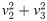
Polytope of possible flux configurations.(A) Example metabolic network with known exchange fluxes v1 and vμ, and two unknown inner fluxes v2 and v3 forming a loop. The upper bounds for fluxes v2 and v3 are UB2 and UB3. Any value of v3 ∈ [0, UB3] satisfy the metabolites’ mass balances, resulting in an infinite set of solutions. (B) Different methods to estimate the inner fluxes. Flux sampling estimates flux configurations from random samples from the set of alternative flux configurations (represented by the points forming the blue line). MinFlux selects the flux configuration where v22+v32 reach their minimum value according to the assumption that cells uses the the minimum amount of fluxes to economize enzyme synthesis. Geometric selects the flux configuration located at the geometric center of the space formed by the alternative solutions. MaxEnt selects flux configuration with the maximum information entropy (Hv).